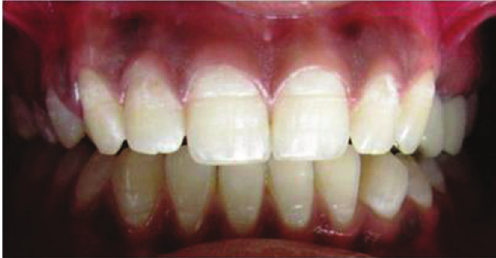
Figure 27: Frontal view at 6-month recall showing functional and aesthetic harmony.